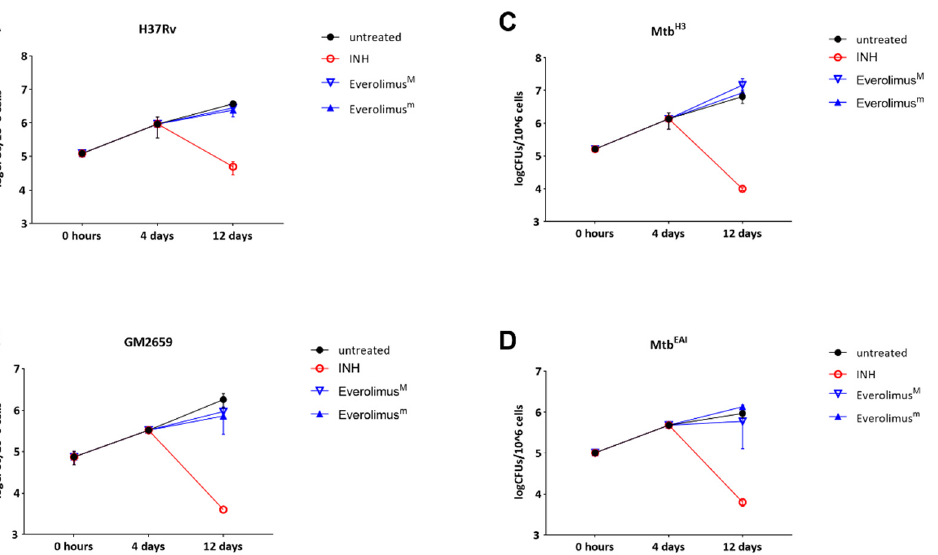
Figure 5. Evaluation of the long-term effect of Everolimus maximal and minimum therapeutic concentrations (Everolimus M and Everolimus m ) in the ex vivo Mtb infection model. Modern ( Mtb H37Rv and Mtb H3 ) and ancient (GM2659 and Mtb EAI ) strains were used to infect peripheral blood mononuclear cells (PBMCs) at MOI = 1:10. Everolimus m (3 ng/mL), Everolimus M (8 ng/mL), and INH (0.2 µg/mL) were added four days post infection. Colony-forming unit (CFU) analysis was performed 4 days post infection and 12 days post infection, and reported for Mtb H37Rv ( A ), GM2659 ( B ), Mtb H3 ( C ), and Mtb EAI ( D ). Average ± SD of CFUs were represented in log10 scale.